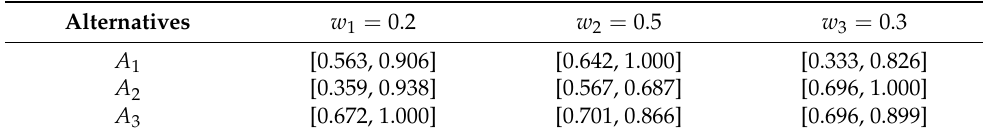
Table 7. Data for evaluation in the fourth example after